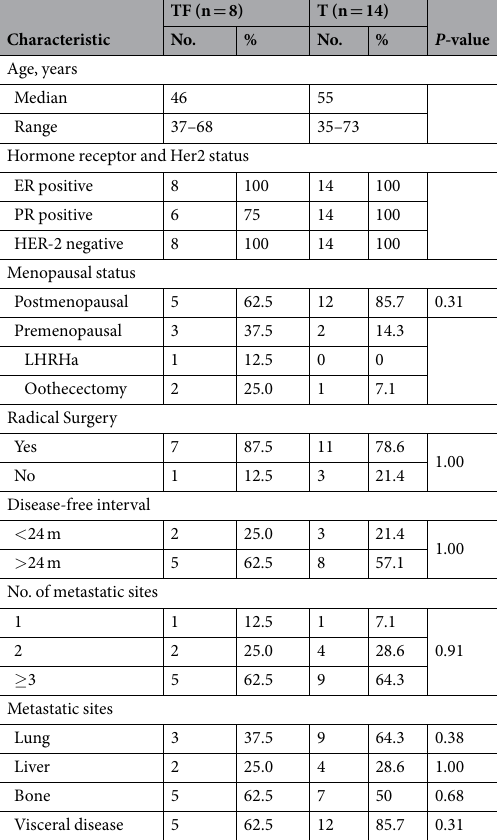
Table 1. Patients and tumor characteristics.